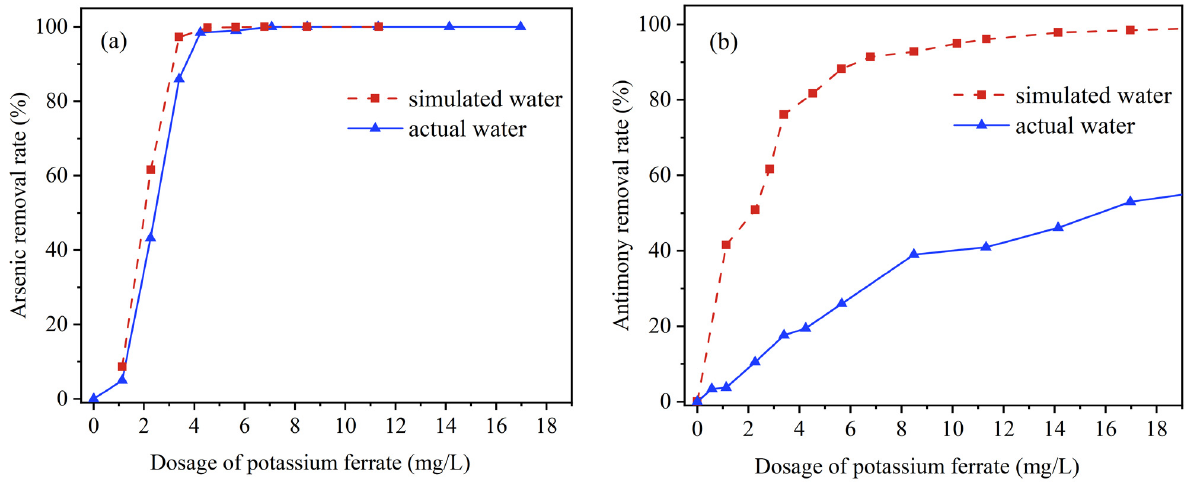
Figure 5. Dosage of K 2 FeO 4 effect on actual water and simulate water (( a ) arsenic removal by K 2 FeO 4 , ( b ) antimony removal by K 2 FeO 4 ).